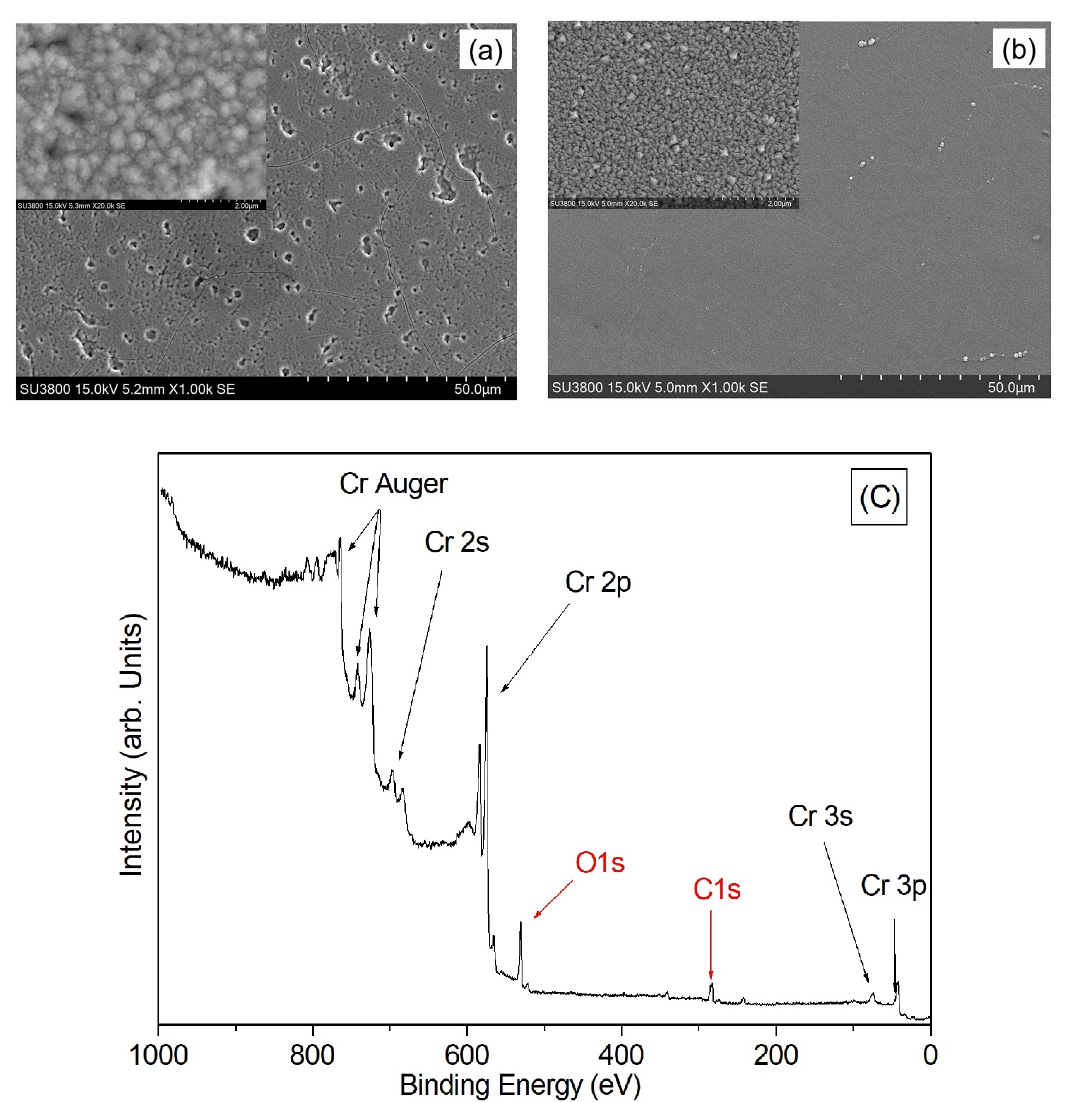
Figure 3. SEM images of the surface topography of ED-Cr, ( a ) and MS-Cr ( b ) coating surfaces. XPS survey spectra of MS-Cr coatings evidencing the presence of peaks only attributable to metallic chromium and atmospheric contaminants (carbon and oxygen) ( c ).